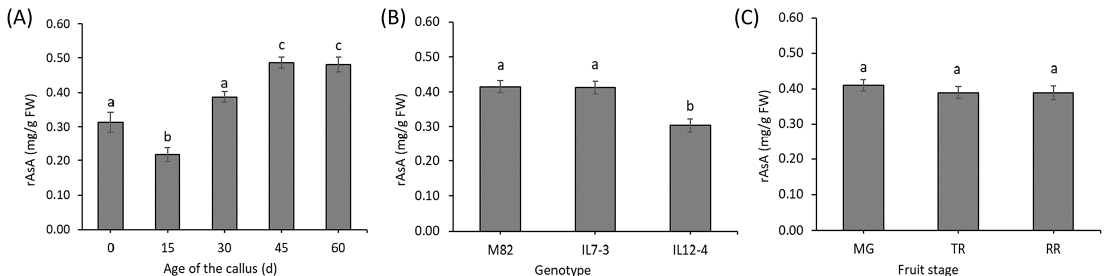
Figure 4. Main effect of the age of the callus ( A ), genotype ( B ) and stage of the fruit used for the tissue culture explants ( C ) on the rAsA content. For each panel, different letters (a–c) represent statistically significant differences ( p ≤ 0.05).